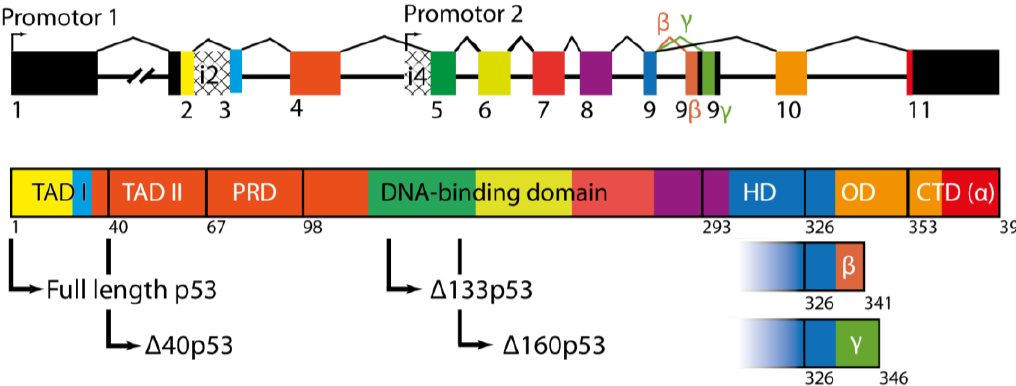
Figure 1. ( Top ) Canonical exons (boxes) and alternative 5 ′ - untranslated regions (UTRs) (checked boxes) of the TP53 gene. The colored exons code for different domains of the p53 protein. Promoter 1 produces a transcript which translates to the full-length p53 (FLp53) and the ∆ 40p53 isoform; the latter is translated only if intron-2 is retained in the transcript. Promoter P2 produces a transcript coding for ∆ 133 and ∆ 160p53 isoforms starting from the 133th and 160th codons. The C-terminal isoforms of p53 (α , β , and γ) are controlled by alternative splicing of the exon 9. ( Bottom ) Different domains of the FLp53 and their correspondence with the exons (shown with the same color code) of the TP53 gene: transactivation domain I (TAD I); transactivation domain II (TAD II); proline rich domain (PRD); DNA-binding domain; hinge domain (HD) oligomerization domain (OD) C-terminal domain (CTD). The arrows indicate the start point (N-terminus) of the particular isoform and determine the domains included in the respective isoform. Bottom right: The open boxes represent the two other C-terminal isoform-variants β and γ